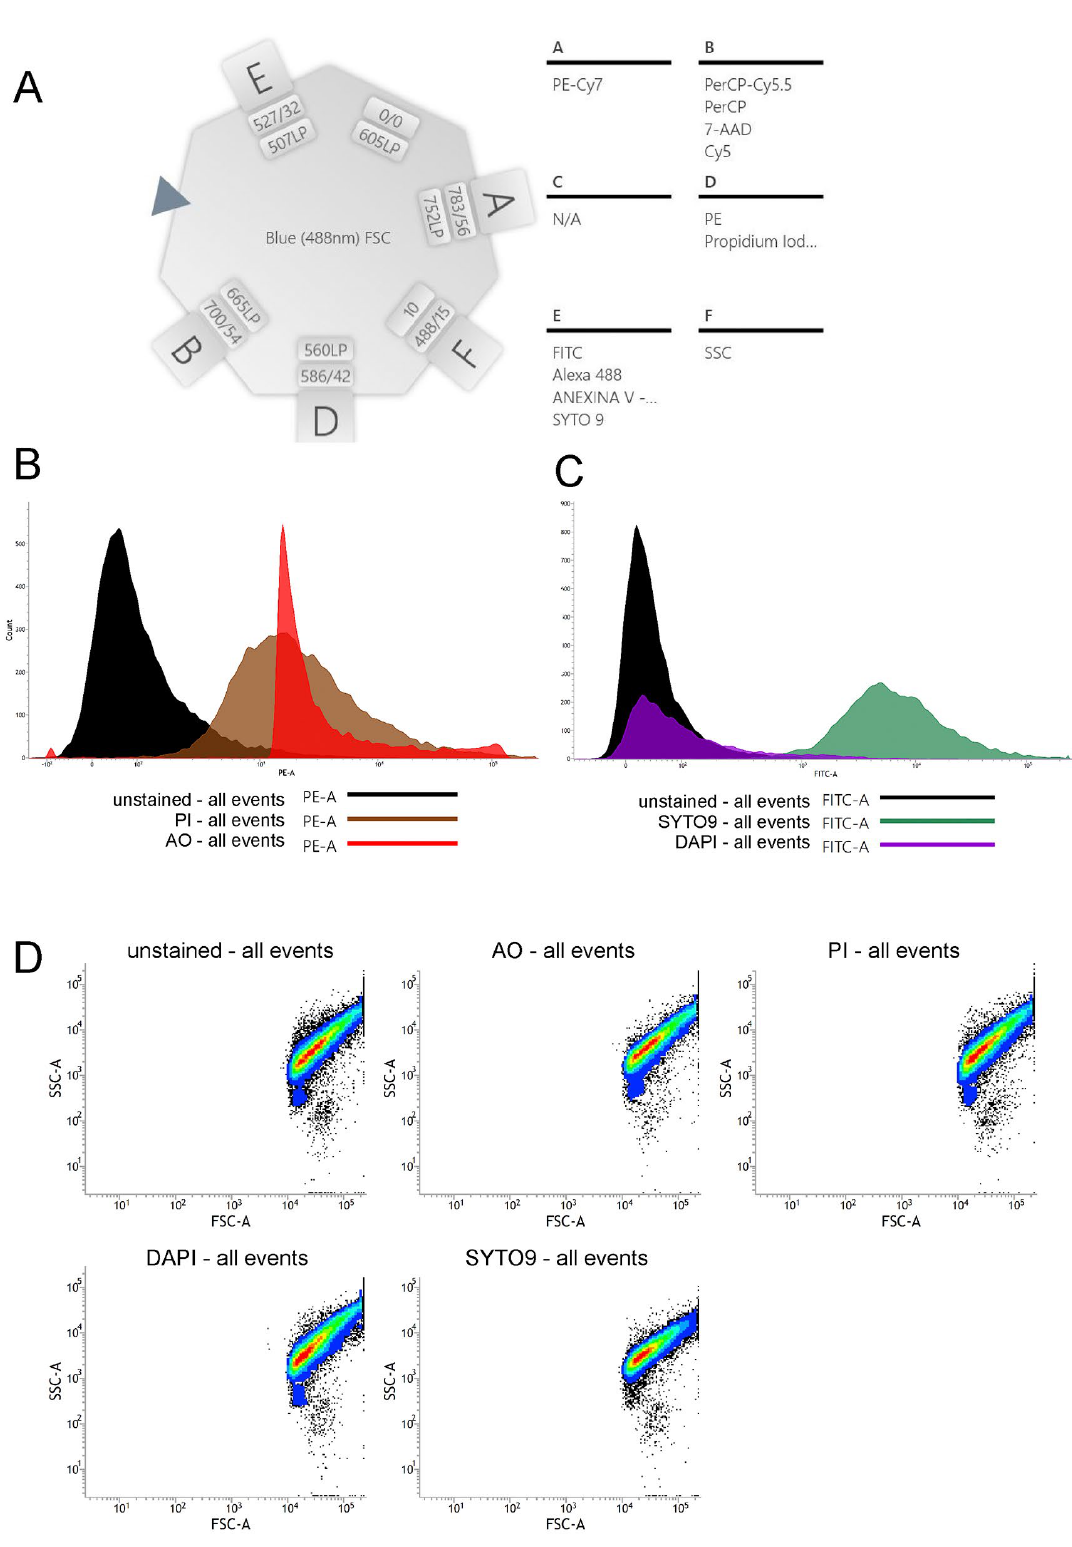
Fig. S3. – A, instrument configuration details of the filters and mirrors used on the BD FACSVerse™. B, histograms show the fluorescence profiles at the FL-3 channel (PE). The curves correspond to the cells unstained and stained with propidium iodide (PI) or acridine orange (AO). C, histograms show the fluorescence profiles at the FL-1 channel (FITC). The curves correspond to the cells unstained and stained with green fluorescent nucleic acid (SYTO9) or 4’-6-diamidino-2-phenylidole, dihydrochloride (DAPI). In both cases, the unstained cells were considered as background and the percentage of those above the background was considered as positive. The fluorochromes were added and analysed separately in each tube, excluding exclude the possibility of interference between them. D, FSC vs SSC dot plot of the bacteria population showing all the events that were considered in the analysis. The FSC vs SSC plot of the stained cells (AO, PI, DAPI, SYTO9) shows that these parameters were similar to those of the unstained